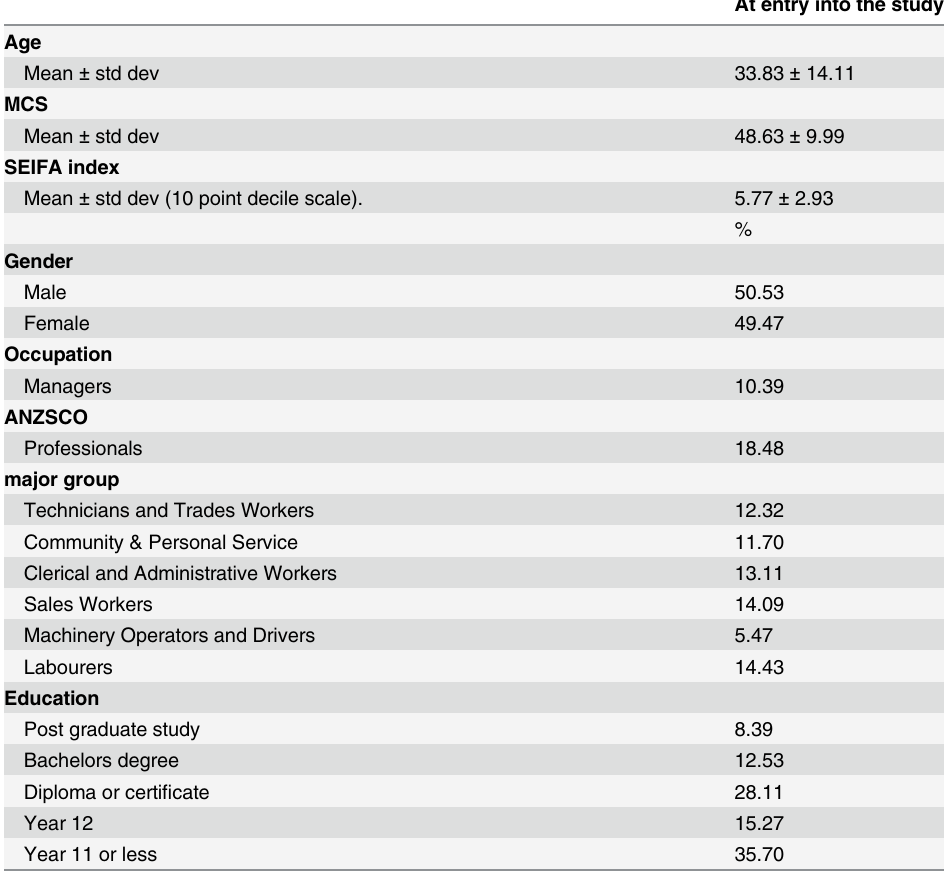
At entry into the